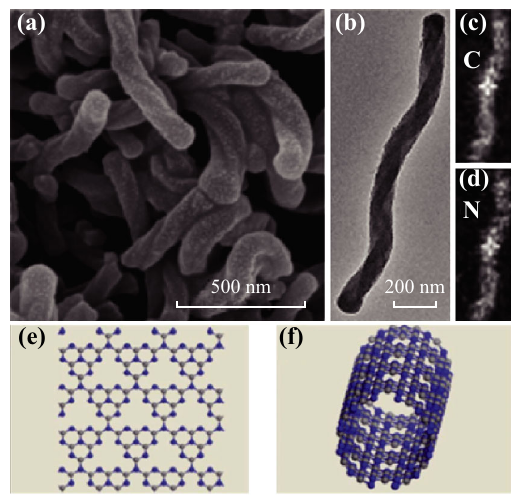
Fig. 6 Morphology characterization of the HR-CN sample. a SEM, b TEM, and c , d corresponding elemental mapping images of g-C 3 N 4 . Reproduced from Ref. [80] by permission of the John Wiley & Sons Ltd. e A g-C 3 N 4 layer and f A single g-C 3 N 4 nanotube formed by rolling the g-C 3 N 4 layer. Reproduced from Ref. [79] by permission of the Royal Society of Chemistry